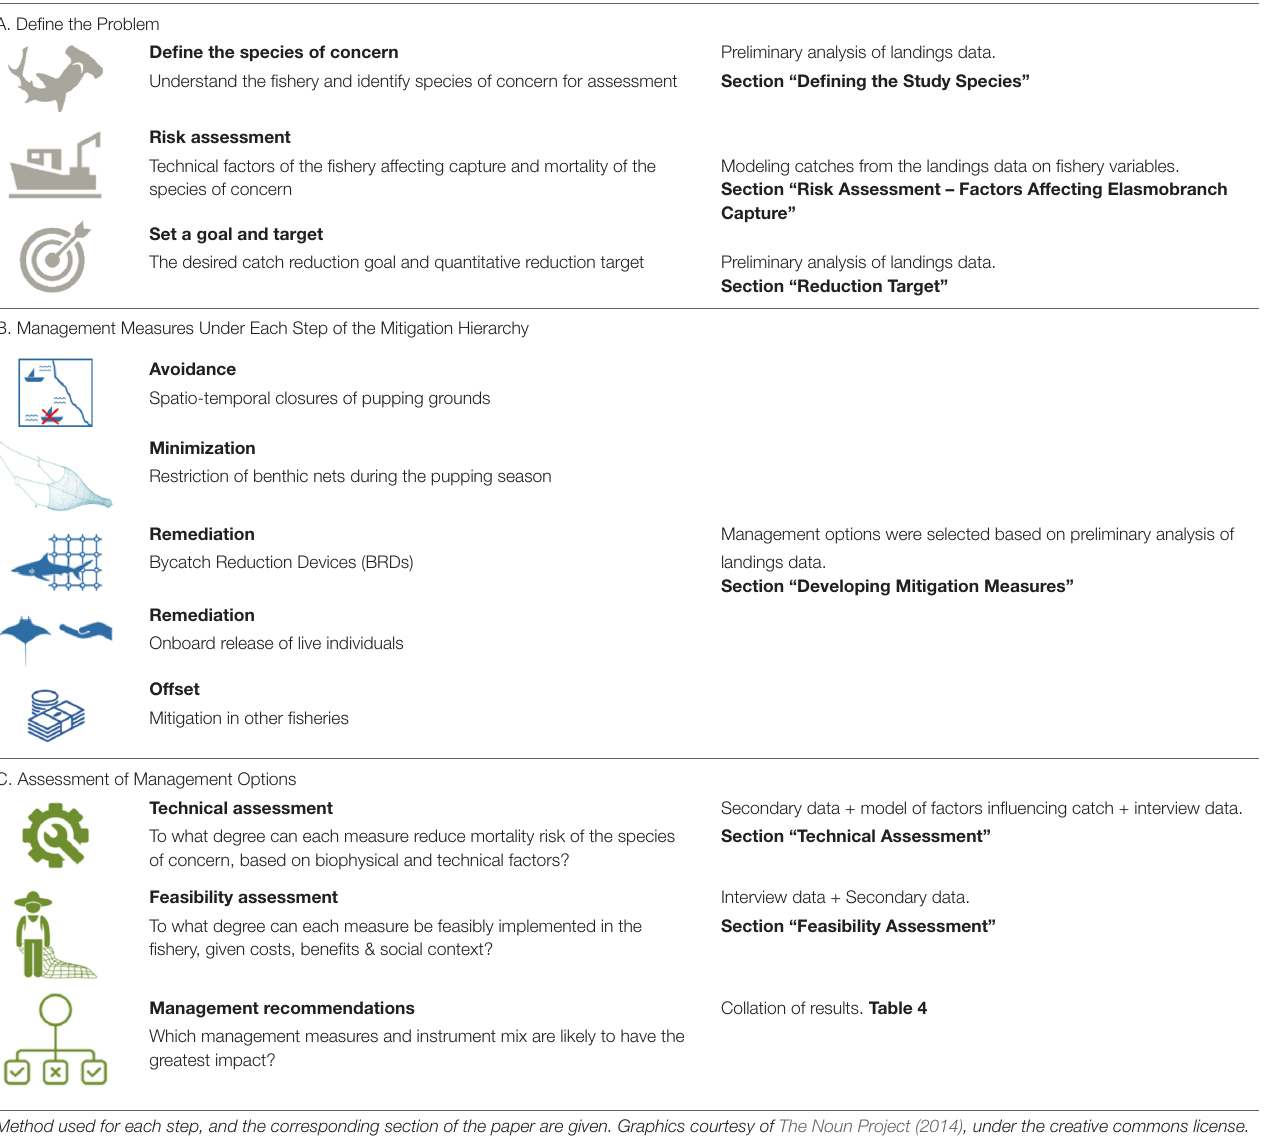
TABLE 1 | The risk-based mitigation hierarchy framework for elasmobranchs adapted from Booth et al. (2019b). Framework